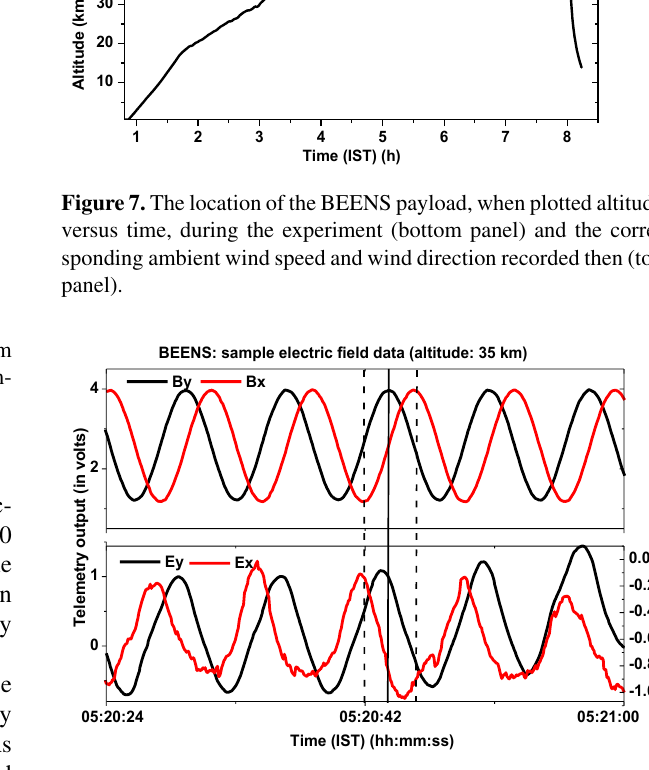
Figure 8. The raw magnetic field data, B x and B y from the x and y sensors, respectively (top panel), and the corresponding electric field